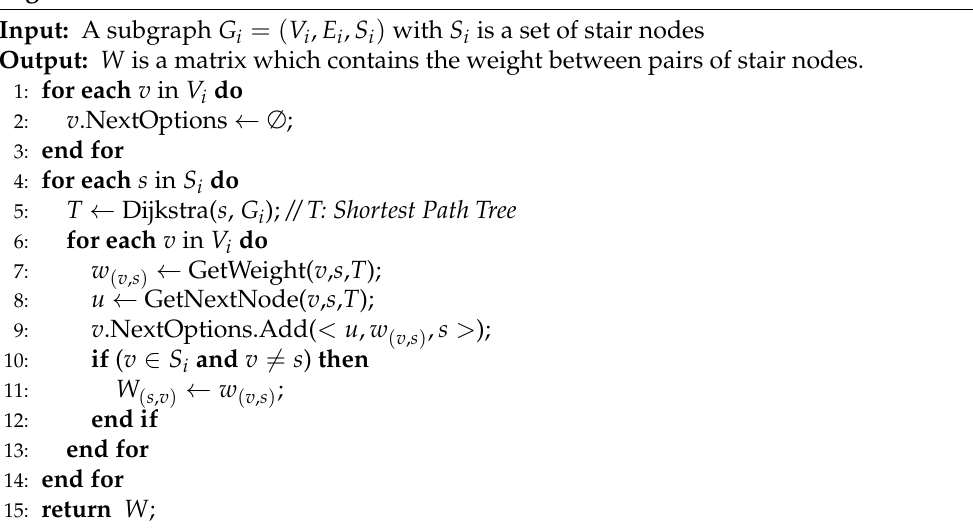
Algorithm 1 LocalEval —Local Evaluation